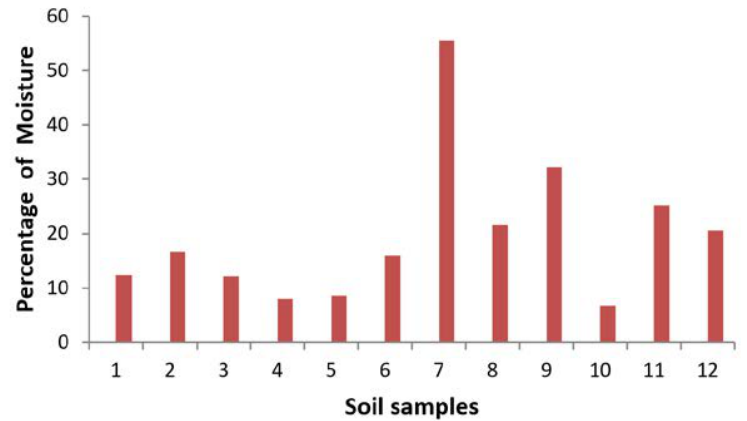
Fig. 1. The pattern of moisture contents of soil samples